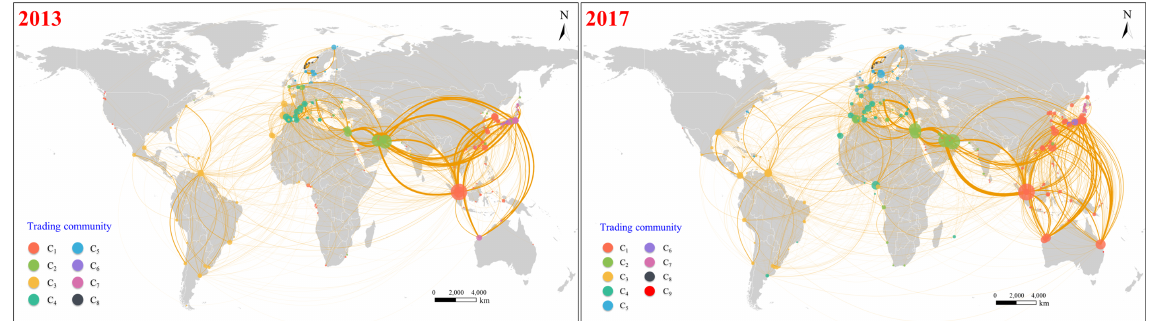
Figure 7. Spatial distribution of ports in different trading communities [12].